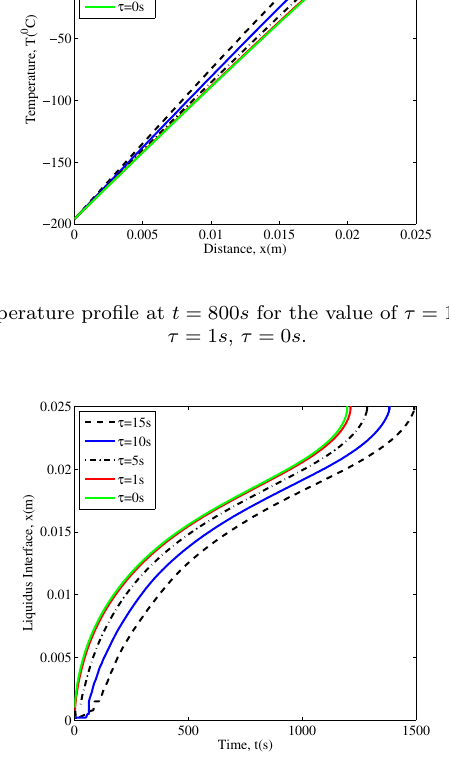
with respect to time at a point, temperature profiles are plotted in Figure 6 and Figure 7 at two test point P ( x = 0 . 01 m ) and Q ( x = 0 . 02 m )